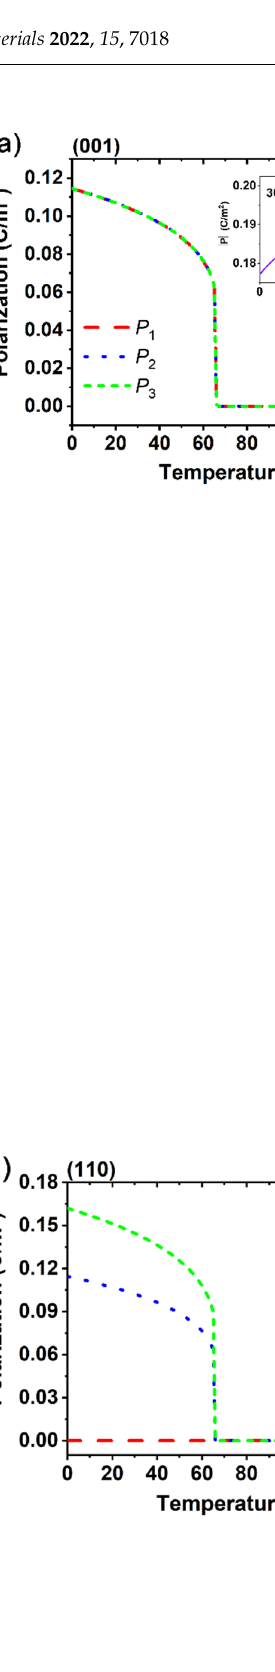
Figure 2. ( a ) Polarizations of (110)-oriented BaZr 0.15 Ti 0.85 O 3 in the absence of an external electric field. ( b ) Dipolar entropy and ( c ) adiabatic temperature change Δ T under different electric fields as a function of temperature.